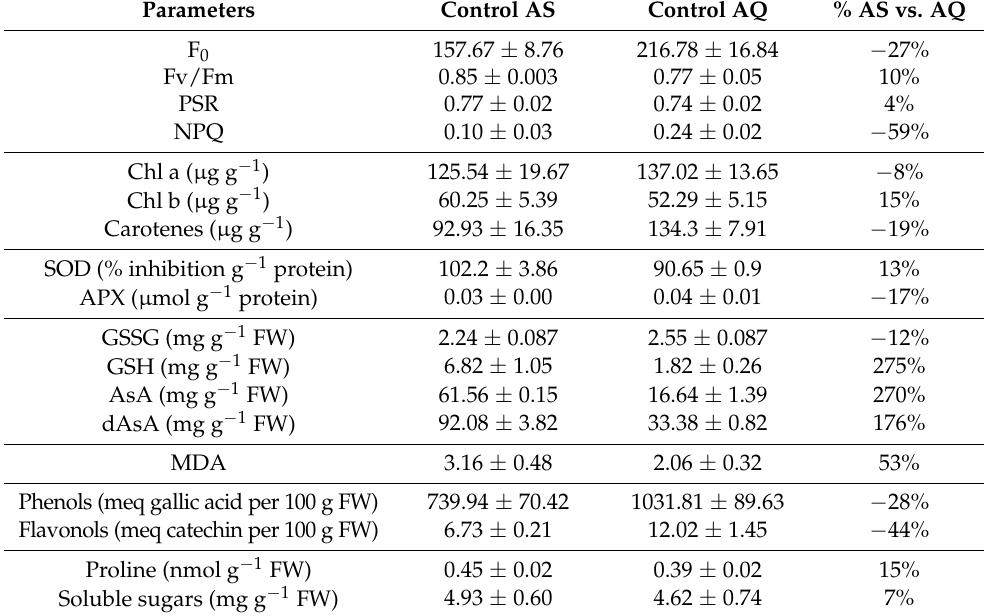
Table 1. Physiological and metabolic characterization of AS and AQ and differences between both expressed as % of variation (increase or decrease) of AS compared to AQ. Values are the average ± SE (n = 3). F 0 , minimum fluorescence; Fv, Maximal Fluorescence; Fv/Fm, maximal PSII quantum yield; NPQ, non-photochemical quenching; PSR: the effective PSII quantum yield; Chl a, Chlorophyll a; Chl b, Chlorophyll b; Carotenes; SOD, Superoxide Dismutase; APX, Ascorbate Peroxidase; GSSG, oxidized Glutathione; GSH, reduced Glutathione; AsA, reduced Ascorbic acid; dAsA, oxidized Ascorbic acid; phenols; flavonols; proline; soluble sugars. Parameters Control AS